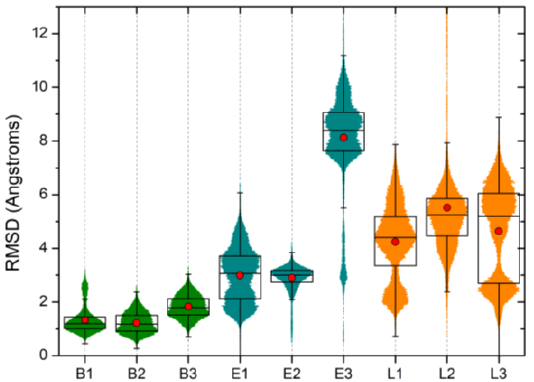
Figure 6. Violin plot of the root mean squared deviation (RMSD) calculated on the heavy atoms of each ligand with respect to the initial docking pose. For each ligand, the results of the three simulations were aggregated in order to increase the sampling. The width of each strip is proportional to the relative RMSD frequency. The average RMSD position is highlighted using a red dot. Each box represents the interval between the end of the first quartile and the beginning of the fourth one. The error bars represent the RMSD standard deviations. “Buried”, “Exposed”, and “Lateral” ligands are in green, cyan, and orange, respectively. See Figure S1 in the Supplementary Information for RMSD vs. simulation time plots.